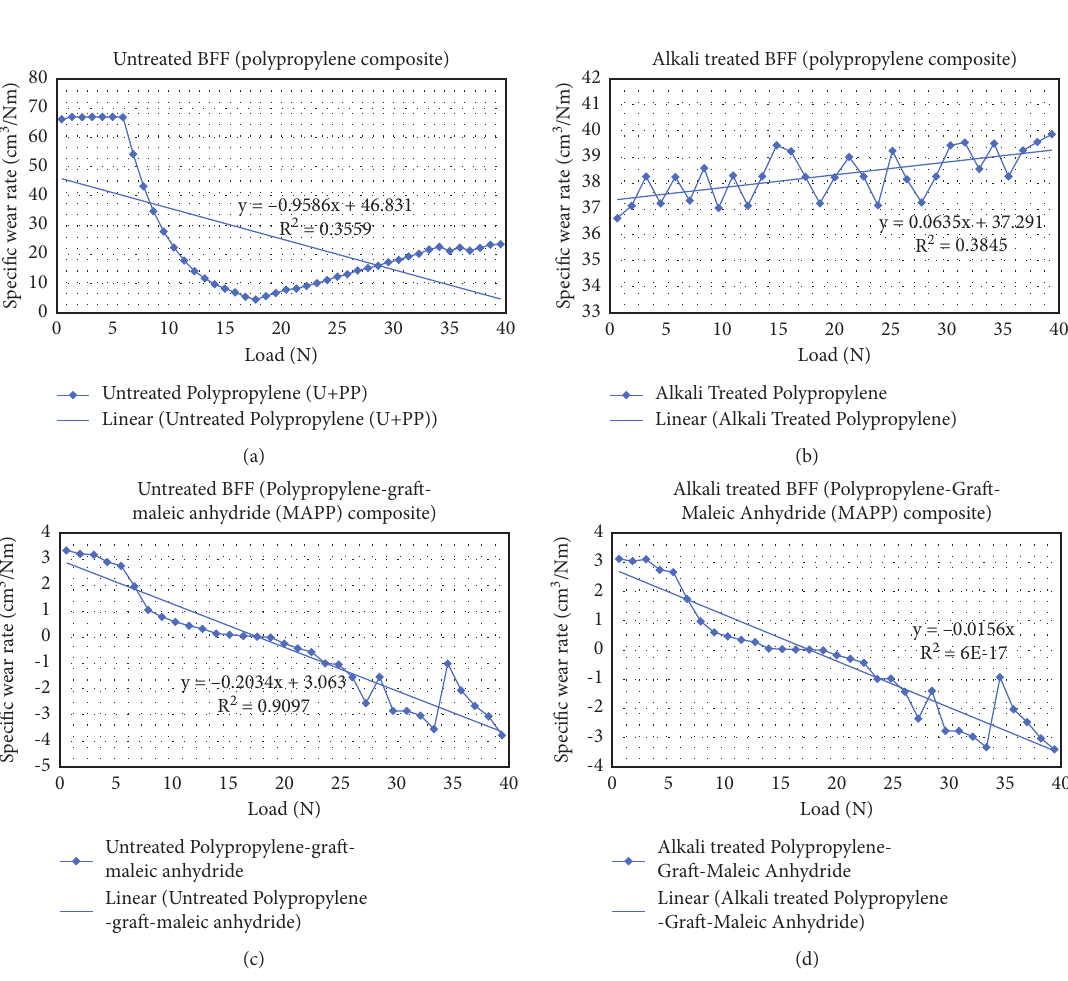
Figure 8: (a–d) Specific wear rate versus applied load of specimens at varying load and sliding distance 4000m.